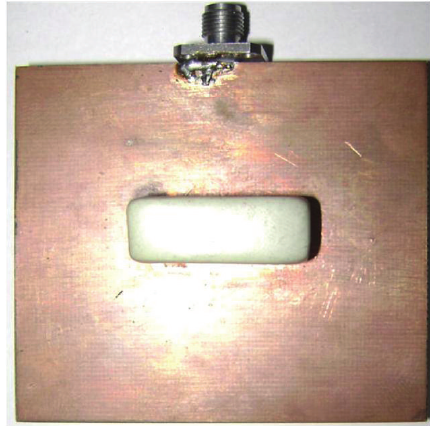
Figure 4: Fabricated model of aperture-coupled DRA.